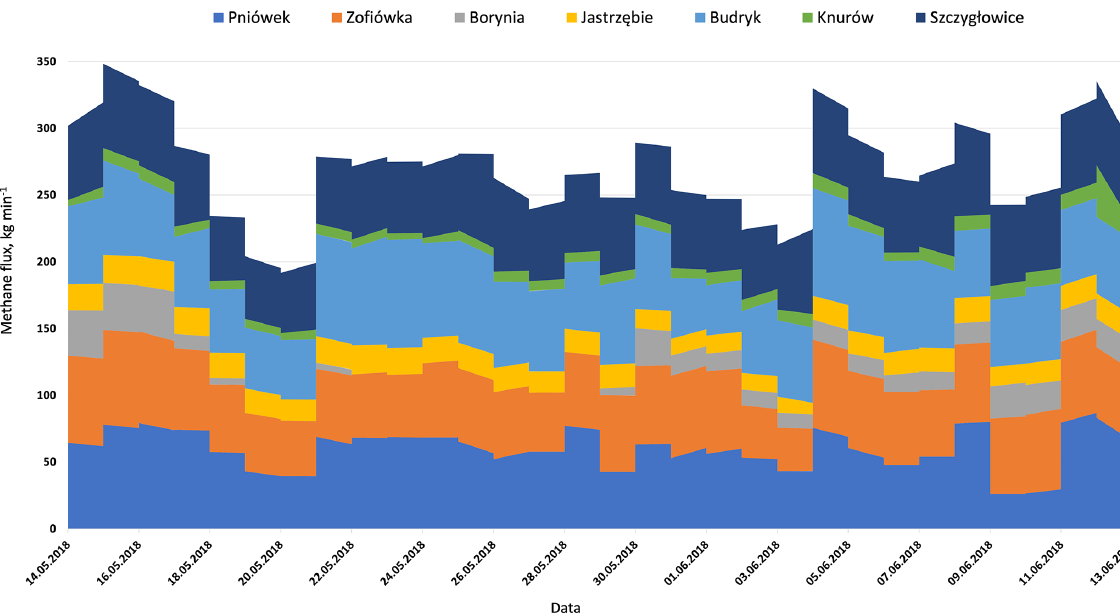
Figure 9. Summary of the methane amount discharged from individual coal mines based on temporal